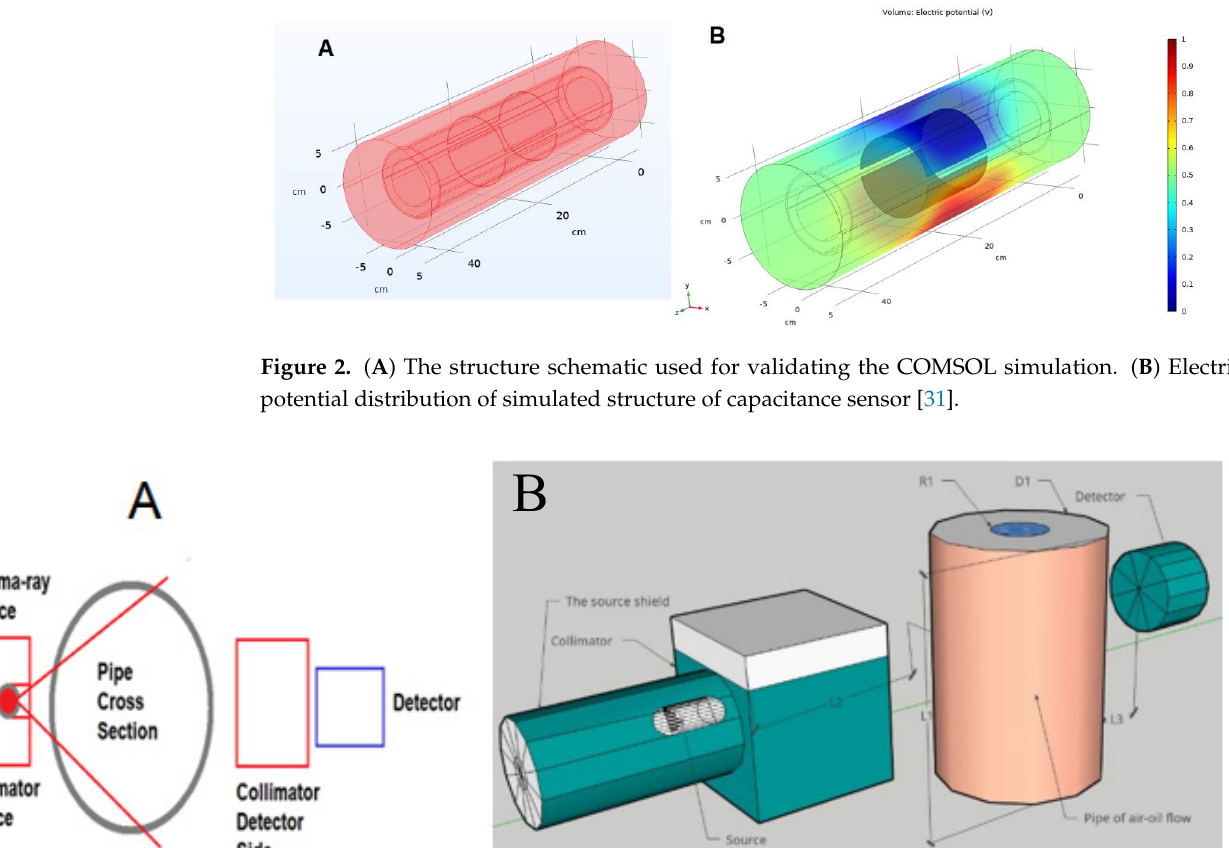
Figure 2 . ( A ) The structure schematic used for validating the COMSOL simulation. ( B ) Electric po- tential distribution of simulated structure of capacitance sensor [31] .